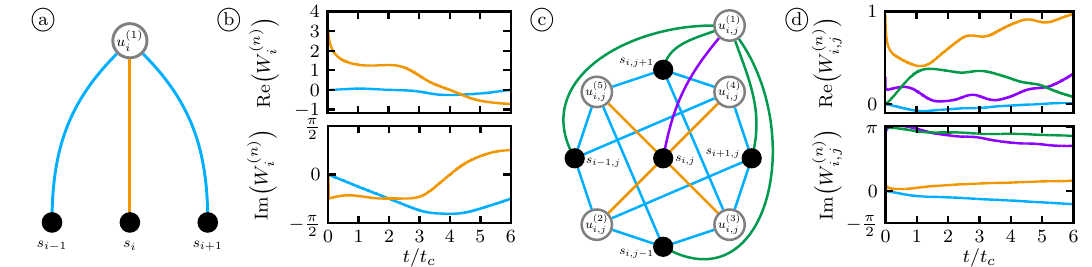
Figure 5: Structure of the ANN for the TFIM in d = 1,2 (a, c) and time evolution of the weights obtained by first-order cumulant expansion for h / J = 0.05 (b, d). In the networks black dots stand for physical spins and gray circles indicate hidden spins. The couplings in (b, d) are color coded with the corresponding lines in (a,